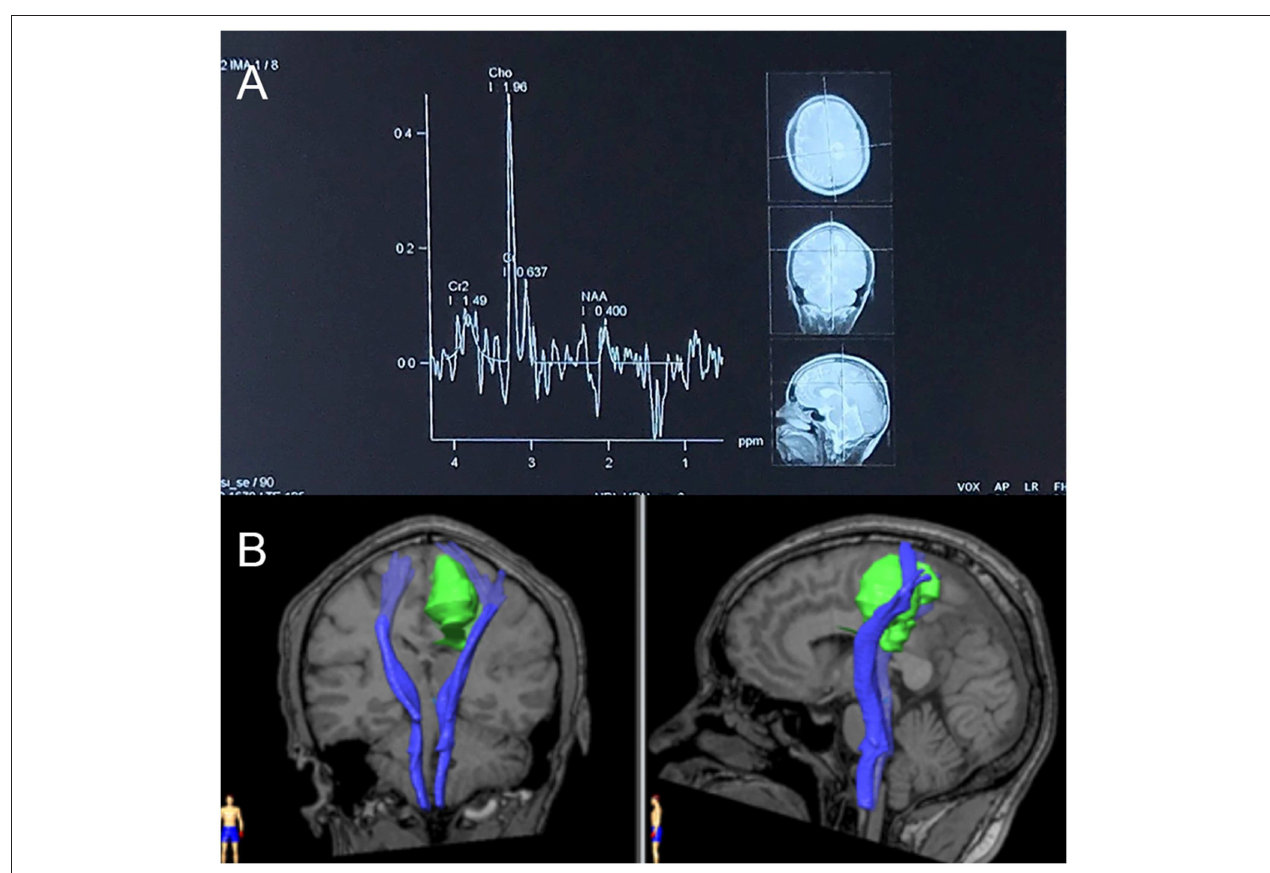
FIGURE 5 | (A) Magnetic resonance spectroscopy (MRS) in September 2018. MRS of peri-enhancement area detected a significantly heightened choline (Cho) peak at 3.2 ppm, and a weakened N-acetylaspartate (NAA) peak at 2.0 ppm. Resonance peak integral of Cho and NAA were 1.96 and 0.40, respectively. The Cho/NAA ratio was 4.9. (B) Diffusion tensor imaging (DTI) in September 2018. Three-dimensional reconstruction images showed an invasion of the lesion into the left pyramidal